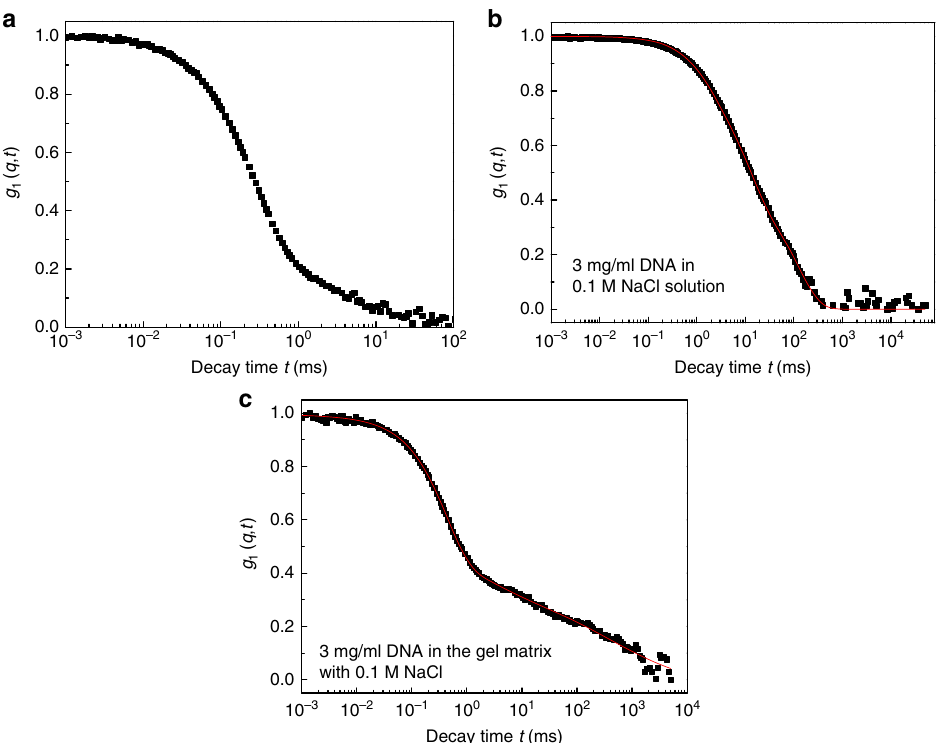
Fig. 2 Typical normalized fi eld-correlation function g 1 ( q , t ) at scattering angle 30°. a The host polyelectrolyte gel, b 3 mg/mL guest DNA molecules in solution and c 3 mg/mL guest DNA embedded inside the host hydrogel. Salt concentration for all samples is 0.1 M NaCl. The red lines are the best fi ts in b ,